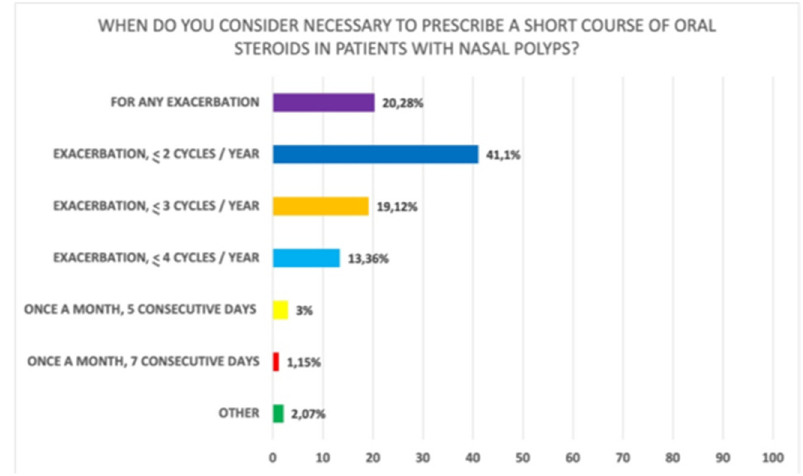
Figure 2. Perceived timing for prescription of a short course of oral corticosteroids in case of re- exacerbation of symptoms (Q17 of Supplementary Materials File).